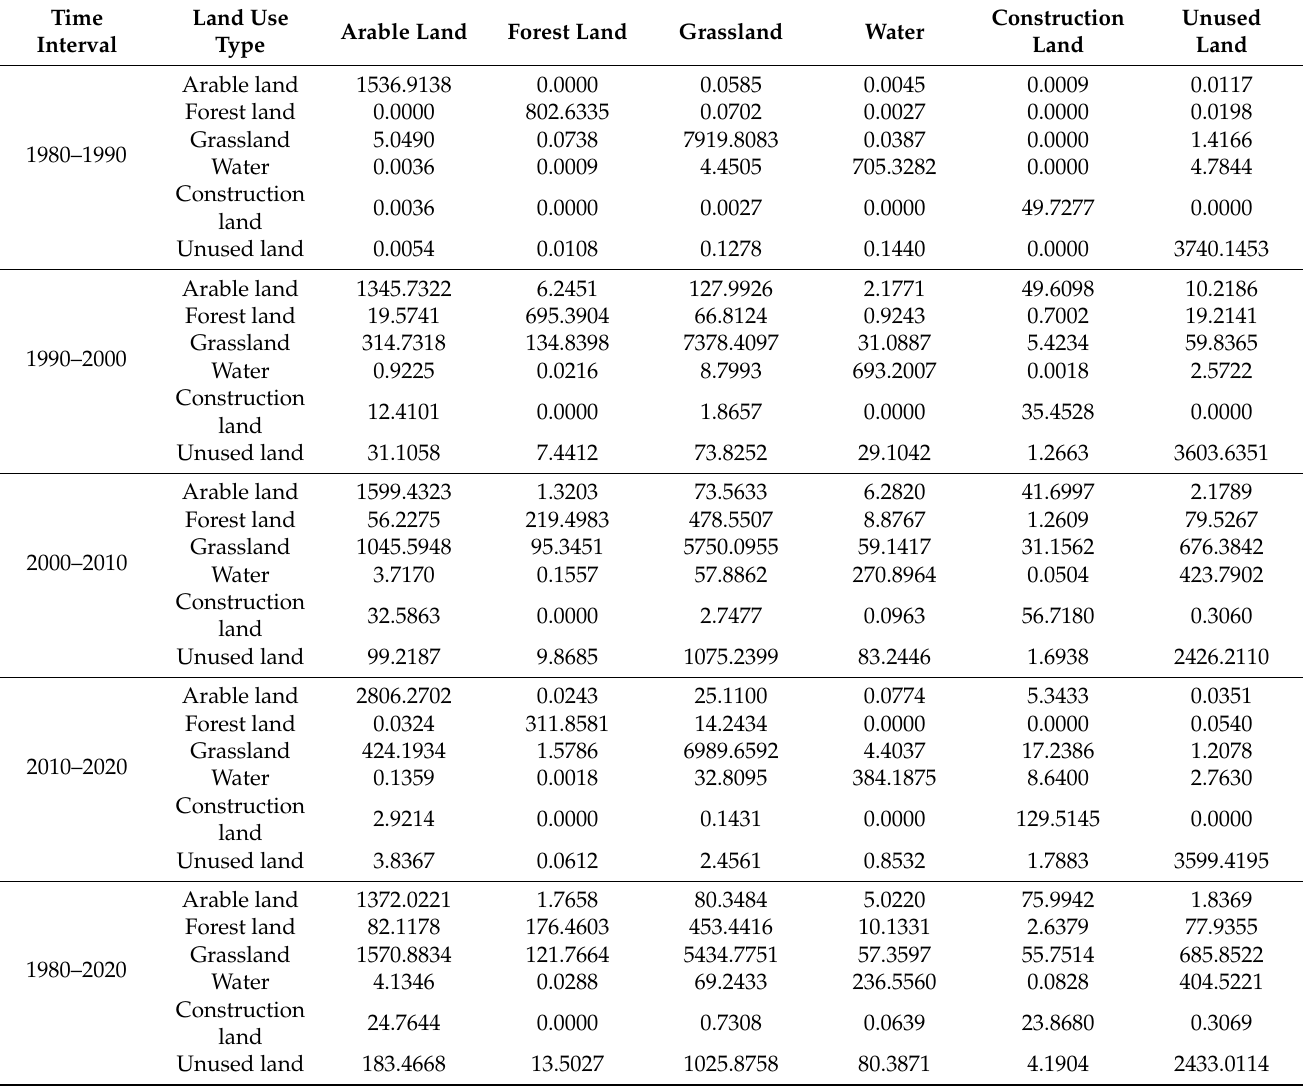
Table 3. Land use transfer matrix (km 2